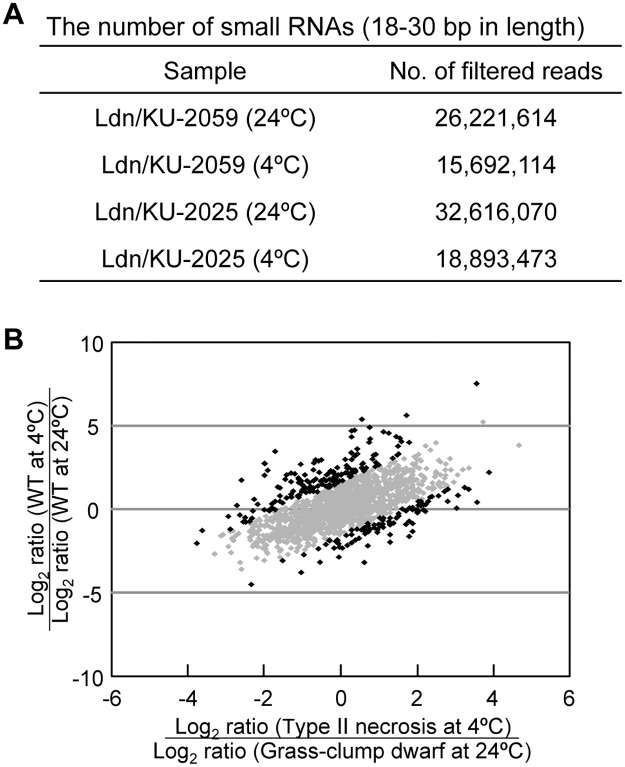
Differentially expressed miRNAs in crown tissues between the WT and type II necrosis/grass-clump dwarf lines.(A) Number of small RNAs from 18 bp to 30 bp in each sample used to identify known and novel miRNAs. (B) Scatter plot of the 1,620 miRNAs expressed in all samples. The x-axis represents the ratio of miRNAs expressed at 4°C and 24°C in Ldn/KU-2025 and the y-axis represents the ratio in Ldn/KU-2059. miRNAs whose ratio between Ldn/KU-2059 and Ldn/KU-2025 was ≥ 2 or ≤ 0.5 are indicated by dark dots.